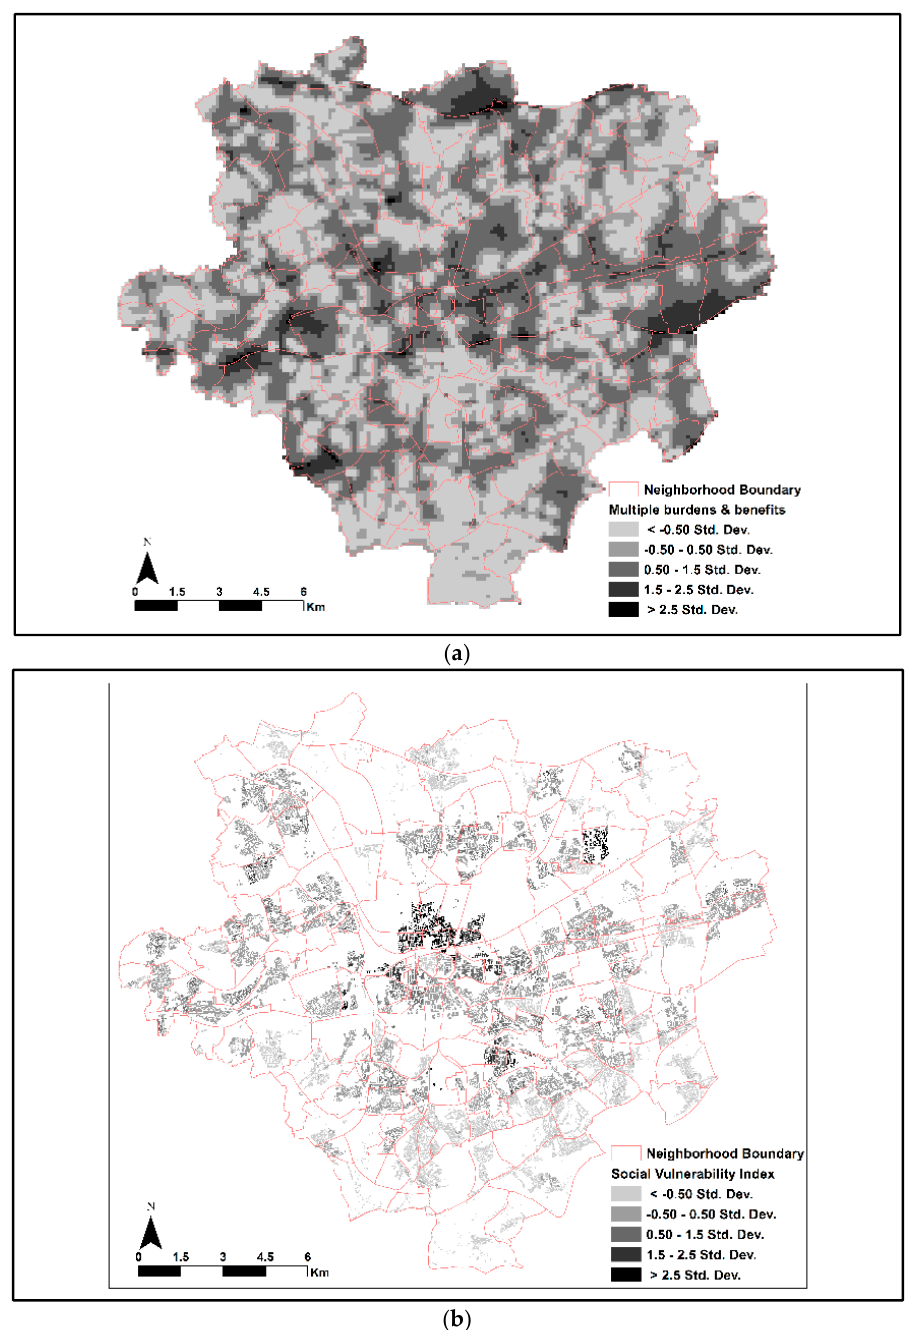
Figure 3. ( a ) Spatial patterns of index score for multiple environmental burdens and benefits in Dortmund; ( b ) Spatial patterns of social vulnerability index score in Dortmund. The positive value of Std. Dev. represents higher cumulated environmental burdens in ( a ) and higher social vulnerability score in ( b ) as compared to the city’s mean. The more negative value of Std. Dev. representing the area has lower cumulated environmental burdens in ( a ) and a lower social vulnerability score in ( b ) as compared to the city’s mean. Finally, the social vulnerability based index of multiple burdens and benefits presented in Figure 4 allows us to identify the spatial pattern of inequalities across the city and enable us to locate “hotspots” (>2.5 Std. Dev.) and “coldspots” (< − 0.5 Std. Dev.) of inequalities, i.e., social units with double burdens of low environmental quality and higher social vulnerability or vice versa.